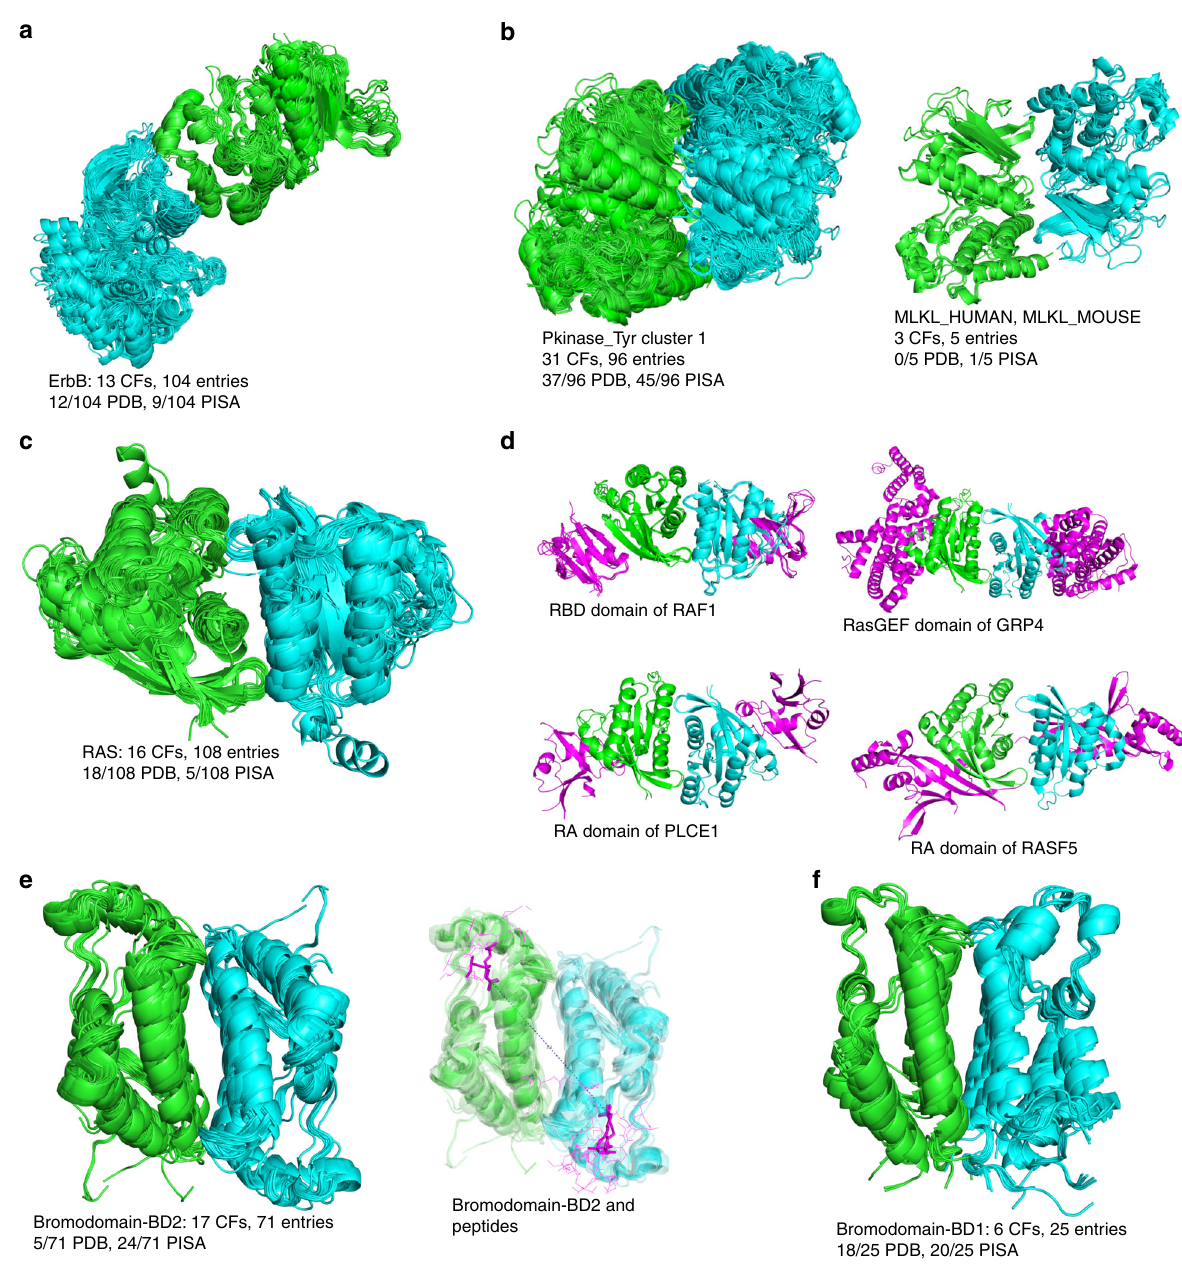
Fig. 3 Hypothesis generation for homodimers. a The asymmetric dimer of ErbB proteins in a ProtCID cluster of 13 crystal forms (CFs) and 104 PDB entries, comprising homodimers of EGFR, ErbB2, ErbB4, and heterodimers of ErbB3 and EGFR (Supplementary Fig. 2); activating monomer in